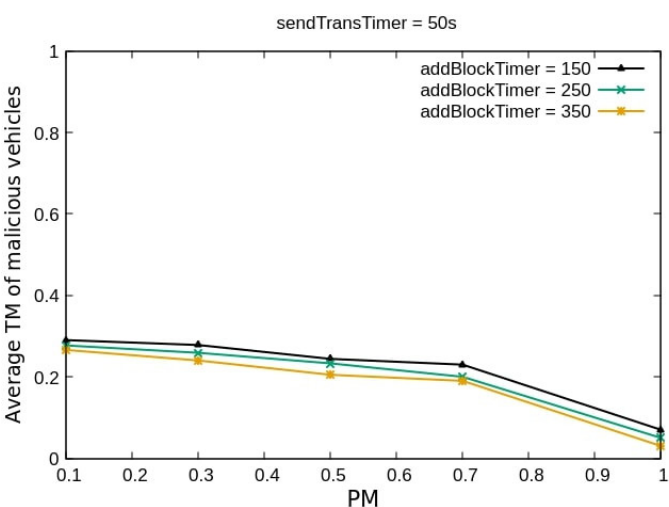
Figure 6. The average trust metric of malicious vehicles vs. PM, sendTransTimer = 50 s .